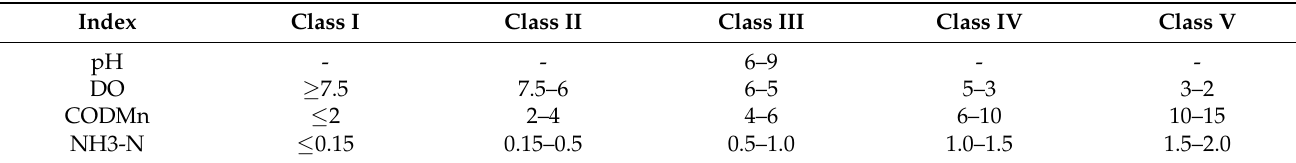
Table 5. Limits of various items of surface water quality